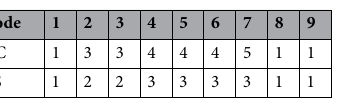
Table 1. The degree and k -shell values of each node in the toy network.